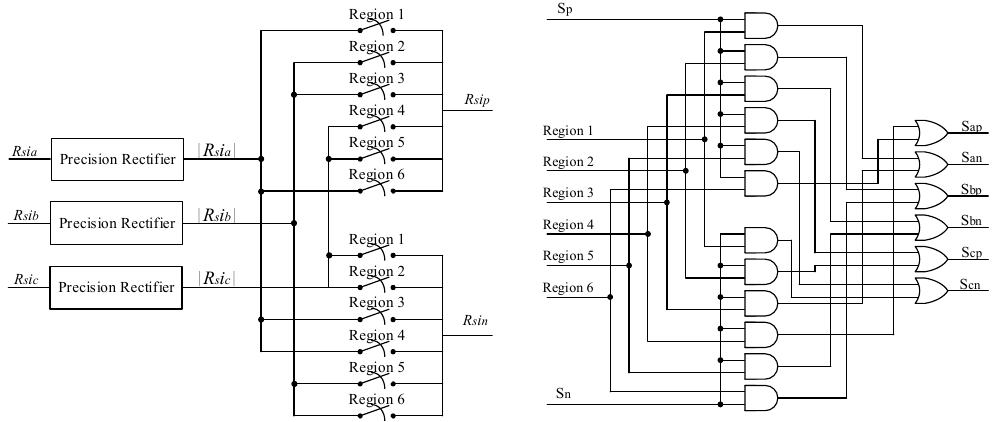
Figure 5. Principle diagram of input and output signal of controller.